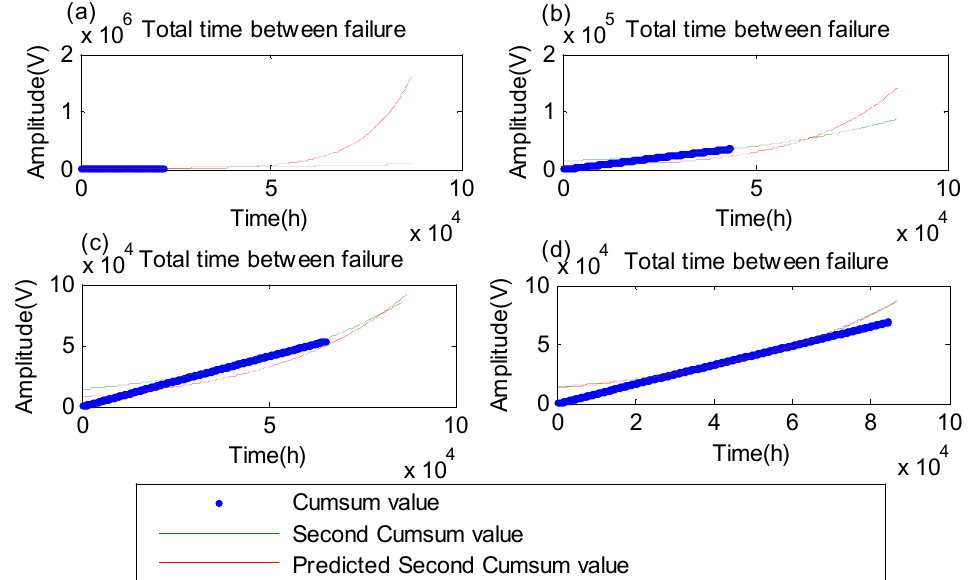
Figure 11. The RUL prognostics results with amplitude of the accumulative signal utilizing the proposed method: ( a ) prognostics result based on 25% of the accumulative data; ( b ) prognostics result based on 50% of the accumulative data; ( c ) prognostics result based on 75% of the accumulative data; ( d ) prognostics result based on 100% of the accumulative